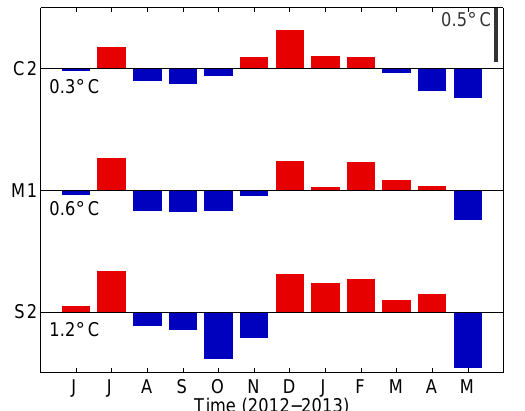
Figure 9. Monthly mean volume transport at (a) mooring array C and (b) array S, per temperature class. The volume transport time series are shorter than a year because records from some current profilers (one at mooring C3 and one at mooring S3) did not cover the whole deployment; see Table